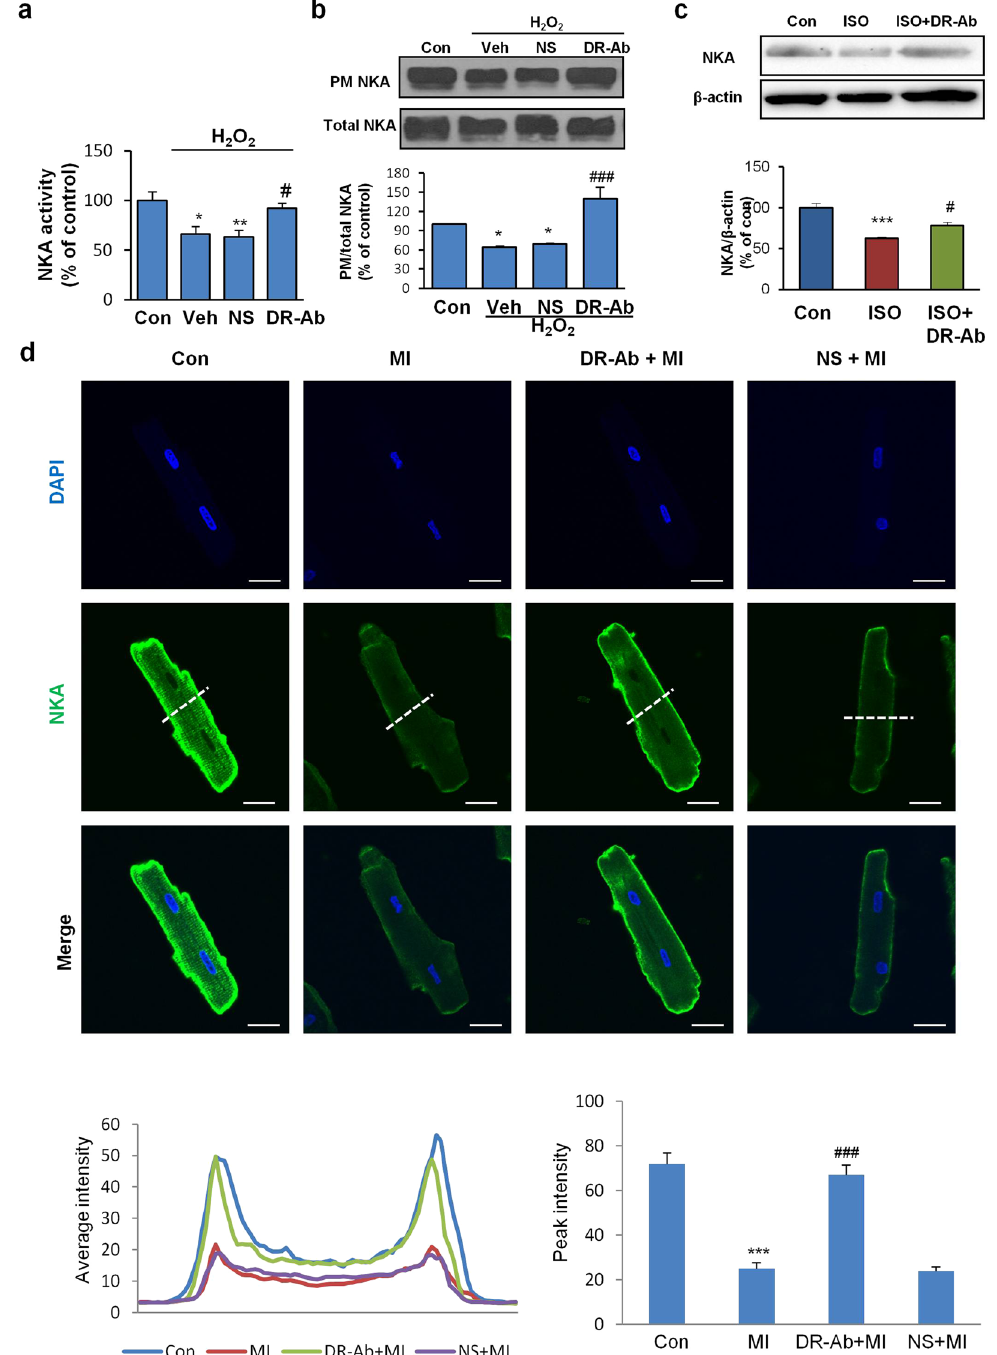
Figure 6. Effect of DR-Ab on the reduced NKA activity and membrane NKA abundance in H 2 O 2 treated AC16 cells and Isoproterenol (ISO)-challenged rat hearts. ( a ) Pretreatment with DR-Ab for 1 hr rescued the inhibition of NKA activity caused by H 2 O 2 (100 μ M, 1 hr). n = 4; ( b ) Representative Western blots and group analysis showing that DR-Ab treatment reversed the plasma membrane (PM) NKA loss in AC 16 cells treated with H 2 O 2 (100 μ M, 1 hr). n = 6; ( c ) Representative Western blots and group analysis showing the effect of DR-peptide immunization on NKA abundance in the rat hearts at the end of 10 weeks post the ISO injection. n = 5; ( d ) Representative confocal immunostaining images showing reduced NKA density on the plasma membrane of isolated rat cardiomyocytes subjected to metabolic inhibition/acidosis (15 min) and normal culture medium (15 min). The lower left panel shows the fluorescent signal intensities of NKA protein collected from the lines across the cells as indicated in the green channel (NKA). The lower right histogram shows a group analysis of plasma membrane NKA staining/peak intensity. Values were the averages from 10 cells in each group. Membrane NKA abundance was maintained in cells pre- incubated with DR-Ab. Con: control, MI: metabolic inhibition/acidosis, NS: Rat normal antibody, as negative control. Scale bar, 20 μ m. Mean ± SEM. * p < 0.05, ** p < 0.01, *** p < 0.001 vs control; # p < 0.05, vs